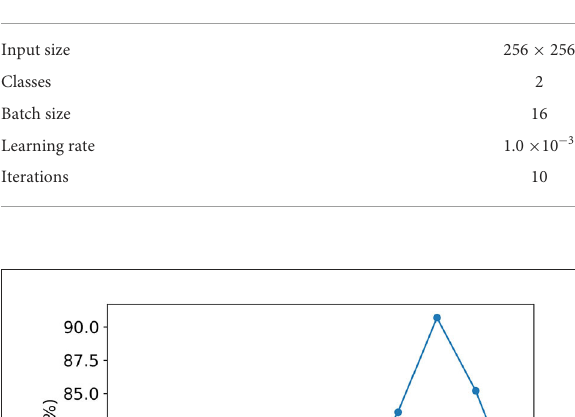
FIGURE8 Accuracy of slight crack detection of cottonseed with different numbers of encoding colors.